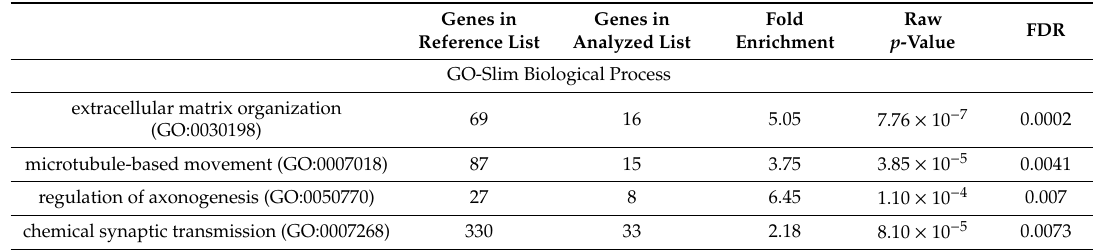
Table 2. Overrepresented GO-Slim terms among differentially expressed genes in AC. The reference list is Homo sapiens UniProt IDs and includes 20996 genes; the analyzed list is comprised of the UniProt IDs for 965 DE genes identified from AC samples. FDR = false discovery rate (significance set at 0.05). A complete hierarchical list of overrepresented terms can be found in Table S4.